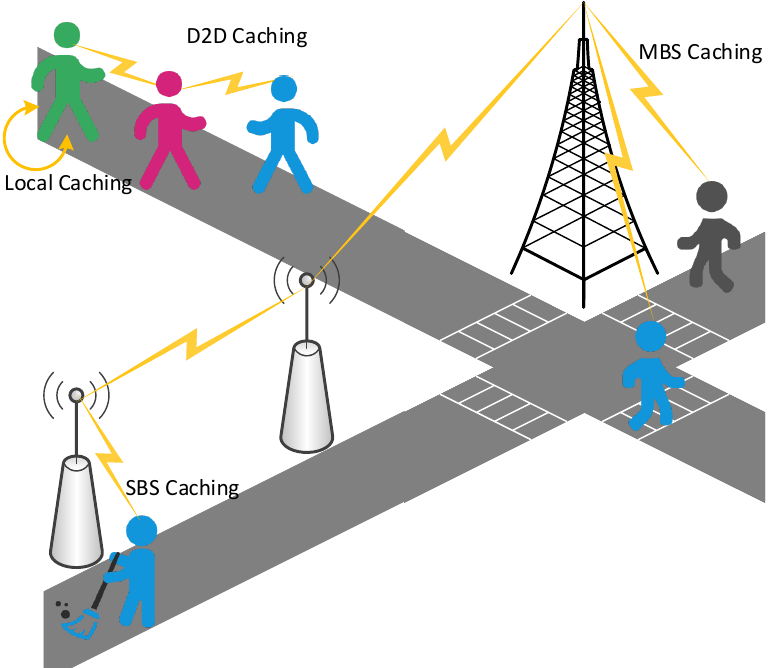
Figure 3. Different caching